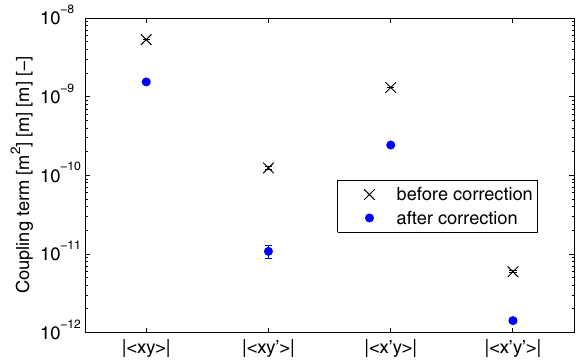
FIG. 8. Coupling correlations before and after the